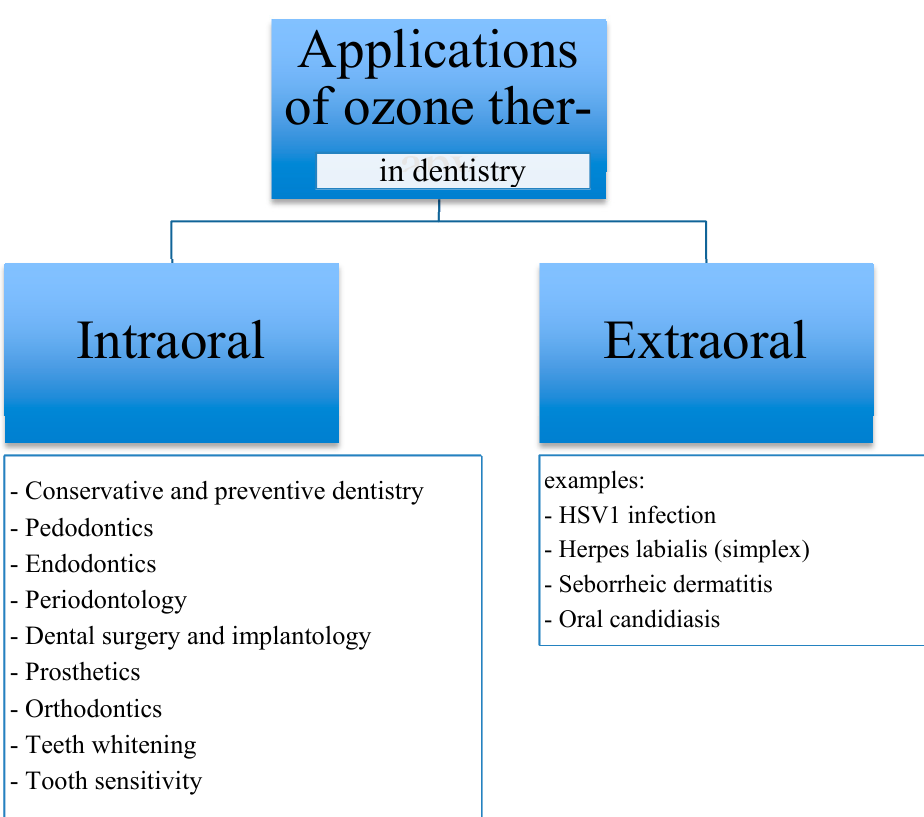
Figure 1. List of intraoral and extraoral applications of ozone therapy in dental specialties.